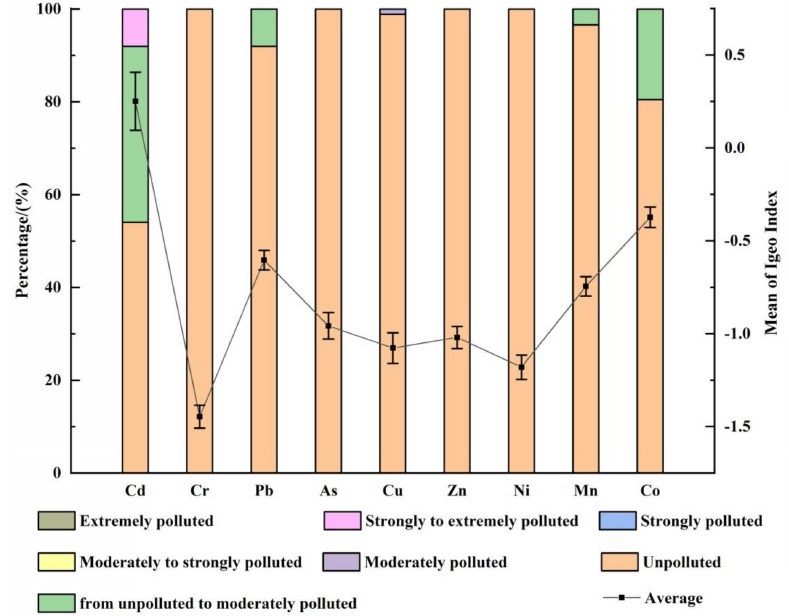
Figure 3. The results of the geo-accumulation index (I geo ) index of heavy metals in the surface soil around Qinghai